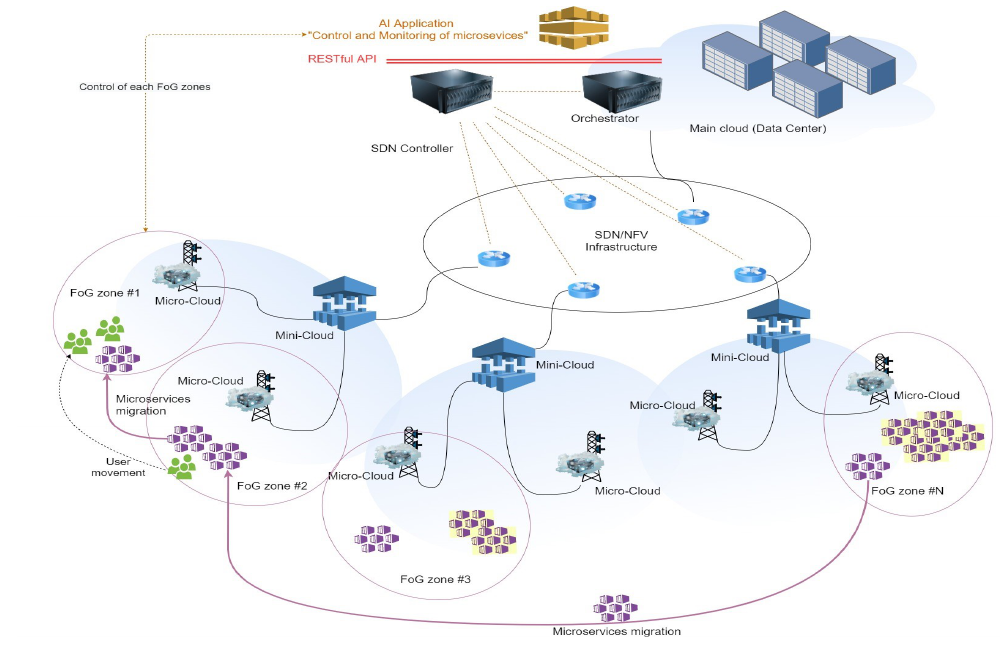
Figure 2. Use case of the framework.